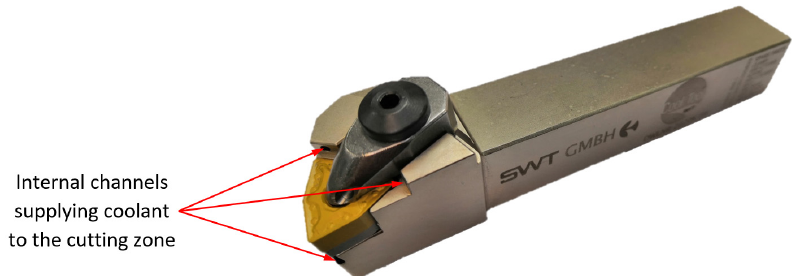
Figure 2. The tool holder with internal cooling channels used in the research.